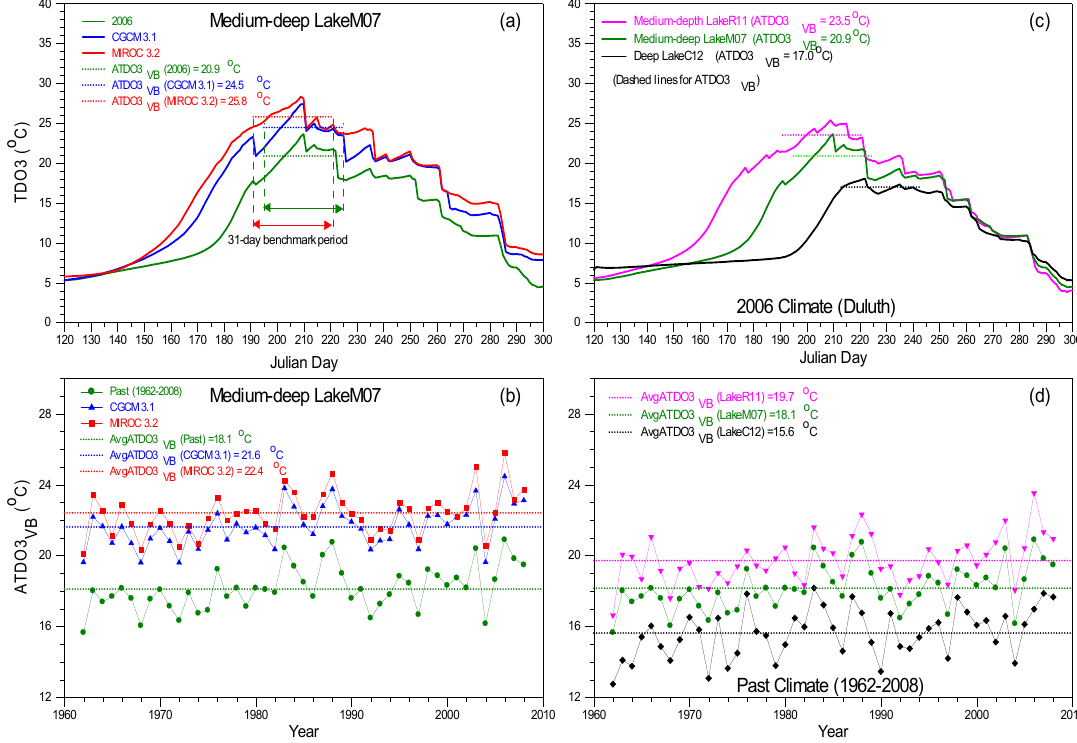
Figure 5. ( a ) Time series of simulated daily TDO3 for LakeM07 in 2006 with dashed lines of ATDO3 VB ; ( b ) time series of ATDO3 VB in LakeM07 with dashed lines of AvgATDO3 VB for the past (1962–2008) and two future climate scenarios; ( c ) time series of simulated daily TDO3 for LakeC12, LakeM07, and LakeR11 in 2006 with dashed lines of ATDO3 VB ; and ( d ) time series of ATDO3 VB in LakeC12, LakeM07, and LakeR11 with dashed lines of AvgATDO3 VB for the past climate (1962–2008). The weather station used for simulations is Duluth.